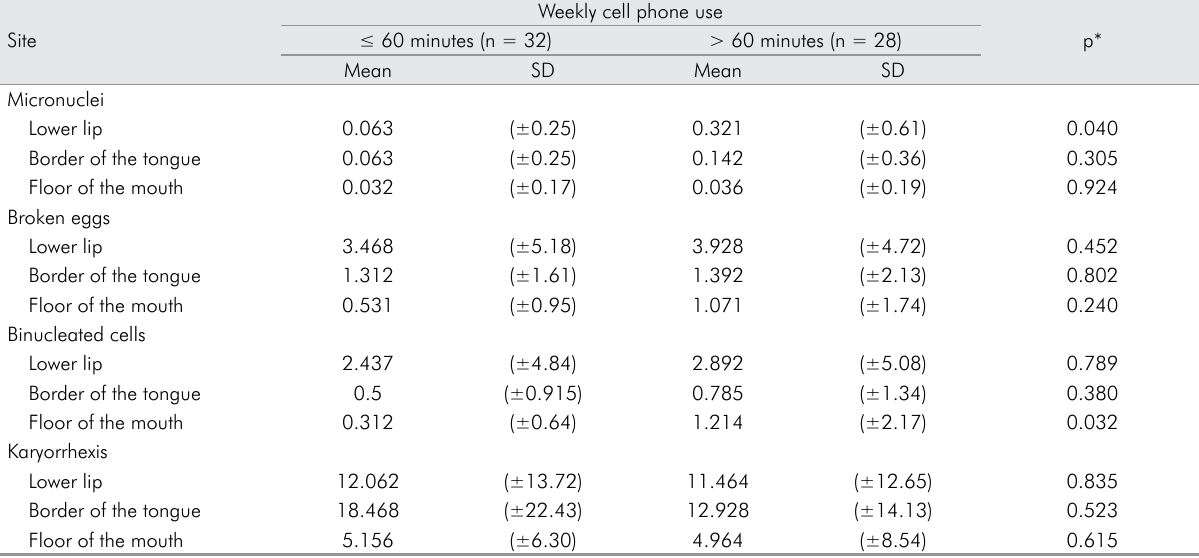
Table 1. Comparison of weekly cell phone use and mean values of nuclear changes at each anatomical site (1,000 cells). Site